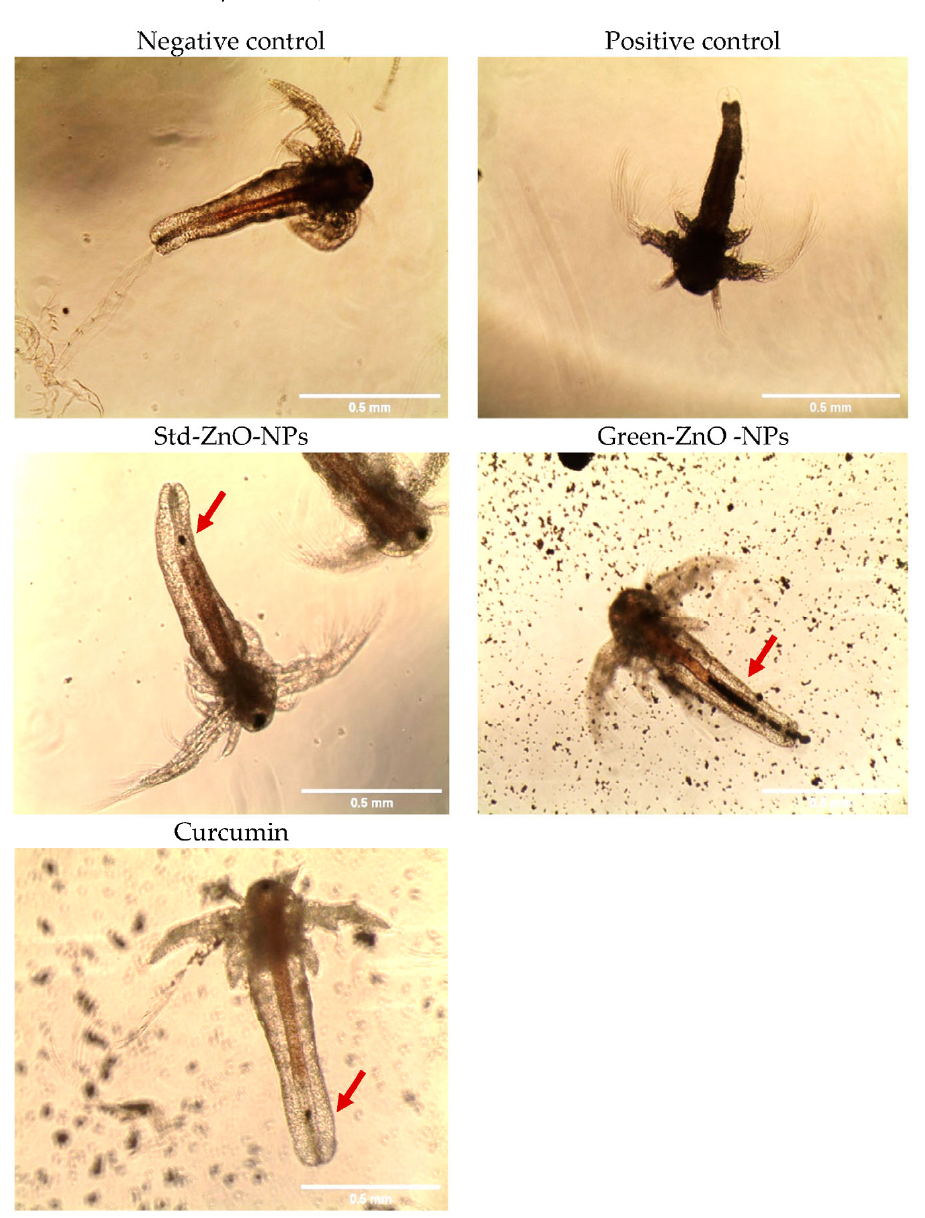
Figure 11. Morphology of treated (at their respective LC 50 ) and untreated Artemia larvae. The red arrows indicate the swallowed treatment by Artemia larvae.